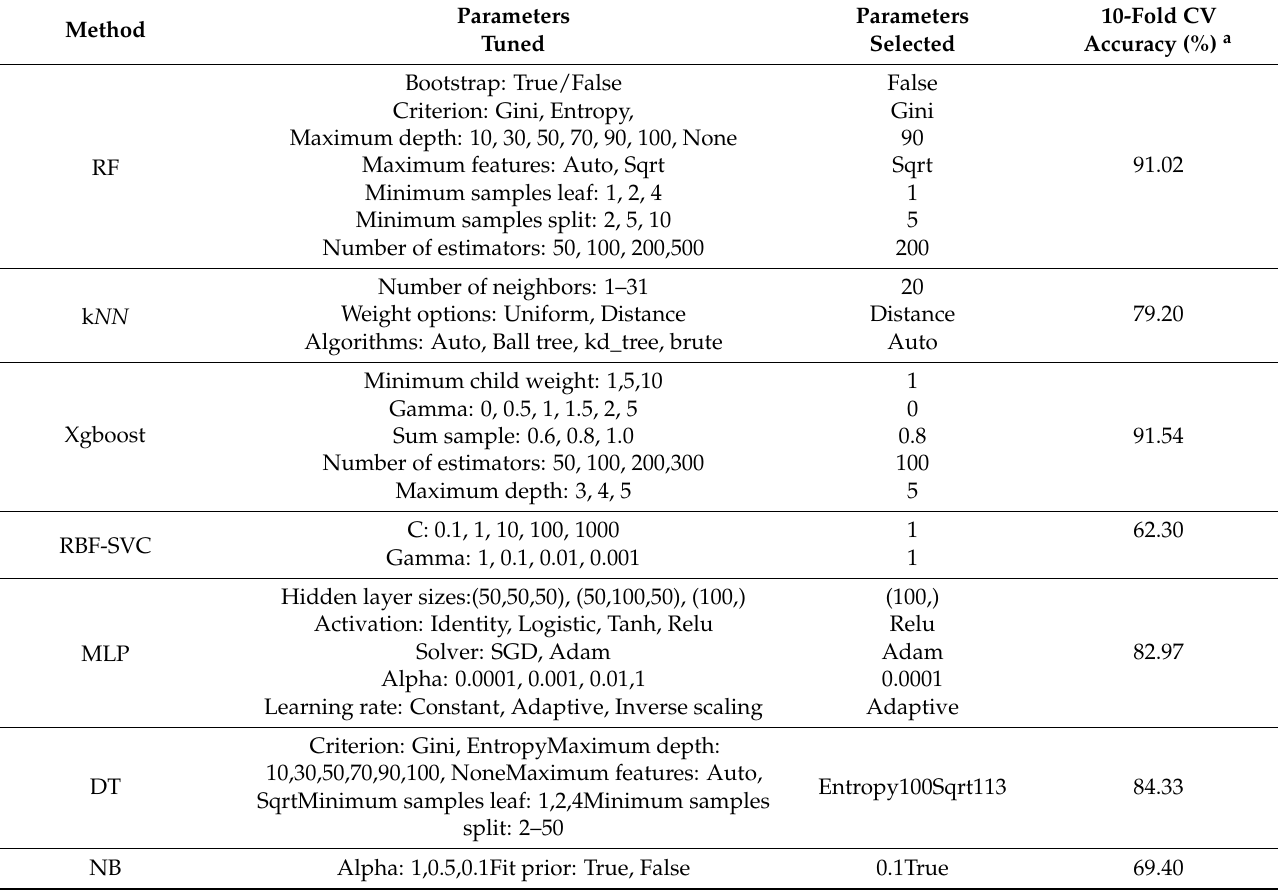
Table 5. Hyper-parameters values explored in the machine learning tools applied for development of the non-linear mt-QSAR